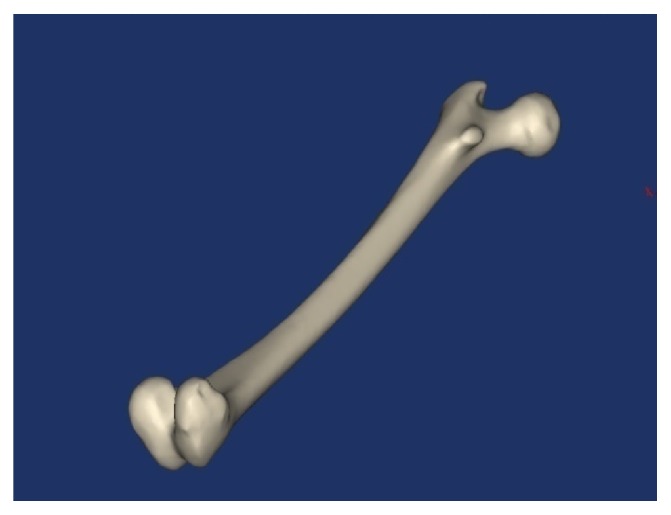
Femoral bone model.